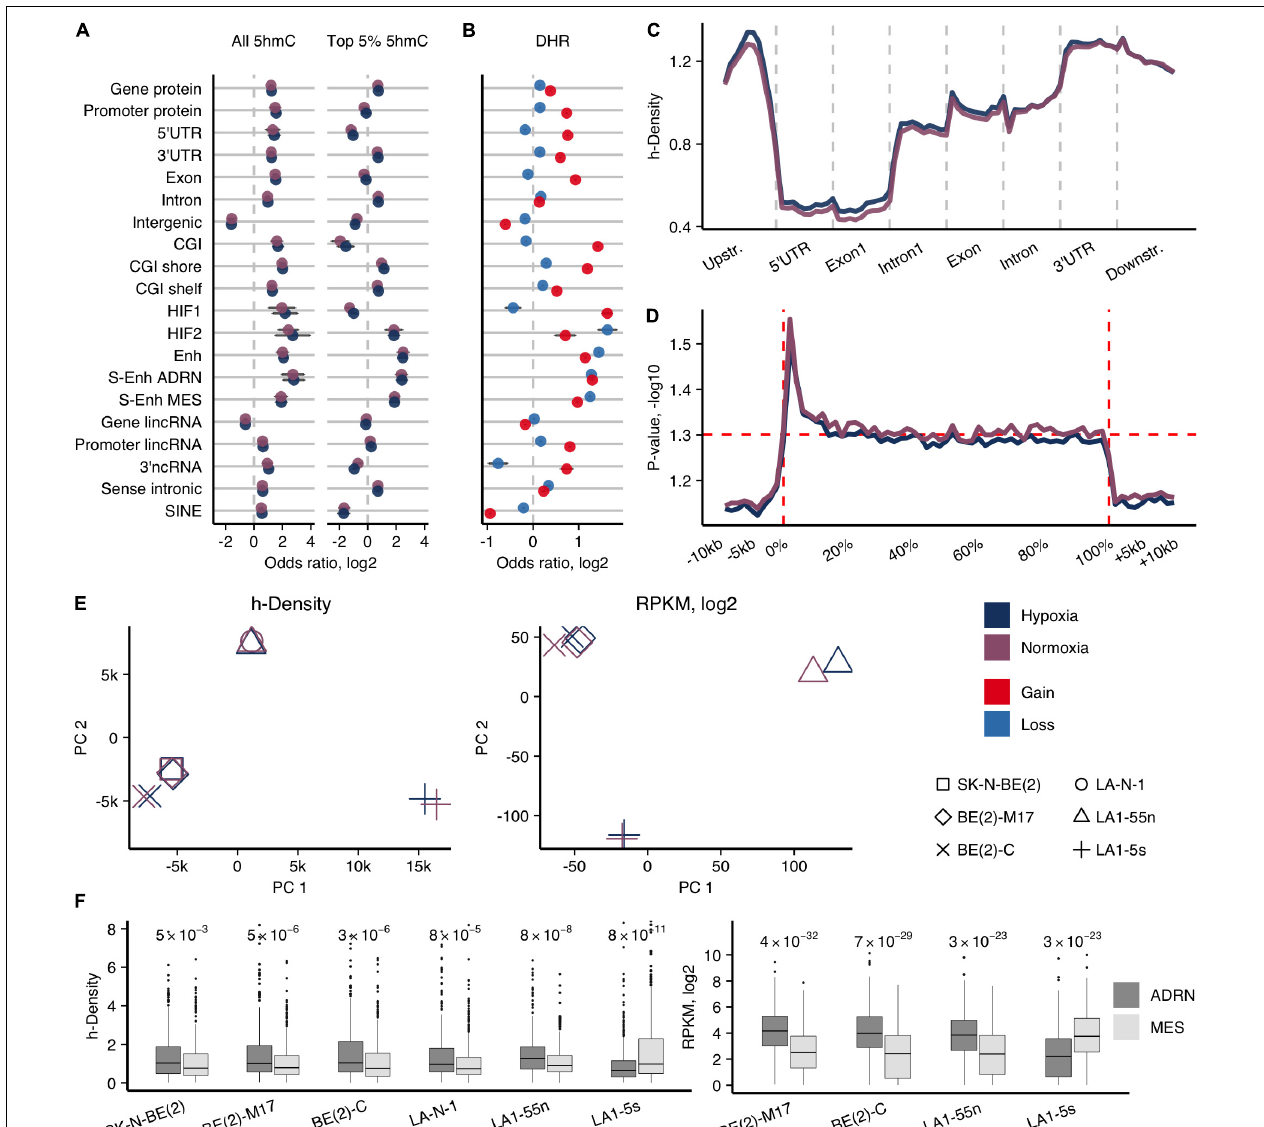
FIGURE 1 | Genome-wide 5hmCG distribution in NB cells. (A) Enrichment odds ratios (OR; log2) of the entire and top 5% h-density signals across various genomic elements for the average signal of NB cell lines. Significance obtained using Fisher’s test, only enrichments with p < 0.05 reported. (B) OR for enrichment of the 1-kb regions with 5hmCG gain and loss (DHRs) across various genomic elements for the average signal of NB cell lines. All p -values for reported OR < 1e-7. (C) Averaged h-density profile over different gene-associated regions: upstream (2 kb), 5 (cid:48) -untranslated (5 (cid:48) UTR), the first exon and intron, other exons and introns, 3 (cid:48) -untranslated (3 (cid:48) UTR), and downstream (2 kb) regions. (D) ANOVA along the protein-coding genes and the upstream, downstream regions ( − 10 kb, +10 kb) for all NB cell lines shows the significant h-density difference along the whole gene body, with the highest difference right after the transcription start site (0% corresponds to TSS, and 100% to TTS). (E) Principal component analysis of h-density (left) and RNA-seq data (right). (F) Distribution of h-density (left) and expression levels (right) across the genes of the ADRN and MES signatures (van Groningen et al., 2017). p -values obtained from two-sided paired t -test.